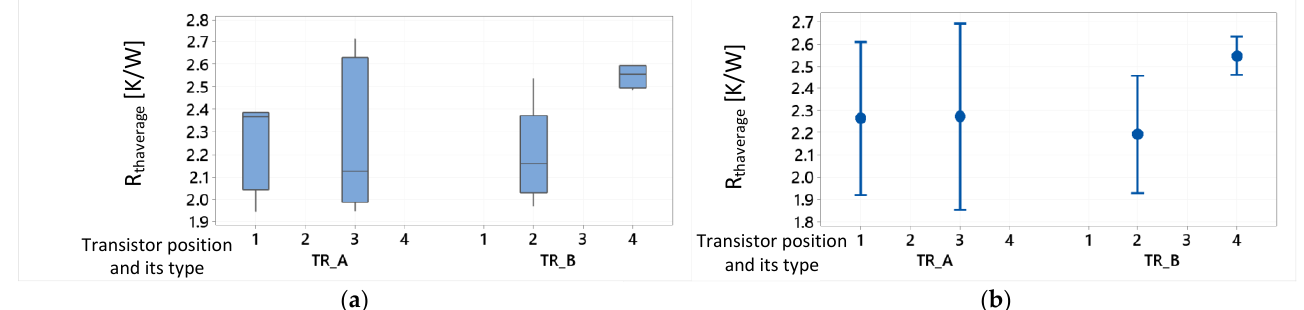
Figure 7. Distribution of the thermal resistance value R th for individual TR_A and TR_B transistors located in individual positions 1 – 4 with the dissipated power P = 21.5W ± 10% ( a ) Box plot and ( b ) Interval plot.